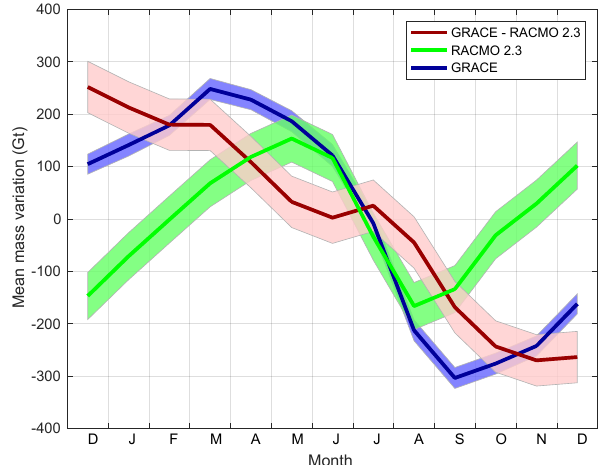
Figure 3. Greenland mean annual cycle of total mass anomalies from GRACE produced with data weighting (dark-blue), cumu- lative SMB anomalies (green), and the difference between them (brown) for the period 2003–2013. The latter curve reflects the cu- mulative sum of seasonal ice discharge variations and meltwater storage, as well as GRACE errors and SMB model bias. The shaded strips show the 1 σ error bars. Labels at the horizontal axis indicate month of the year (e.g., month “J” denotes January, while month “D” is